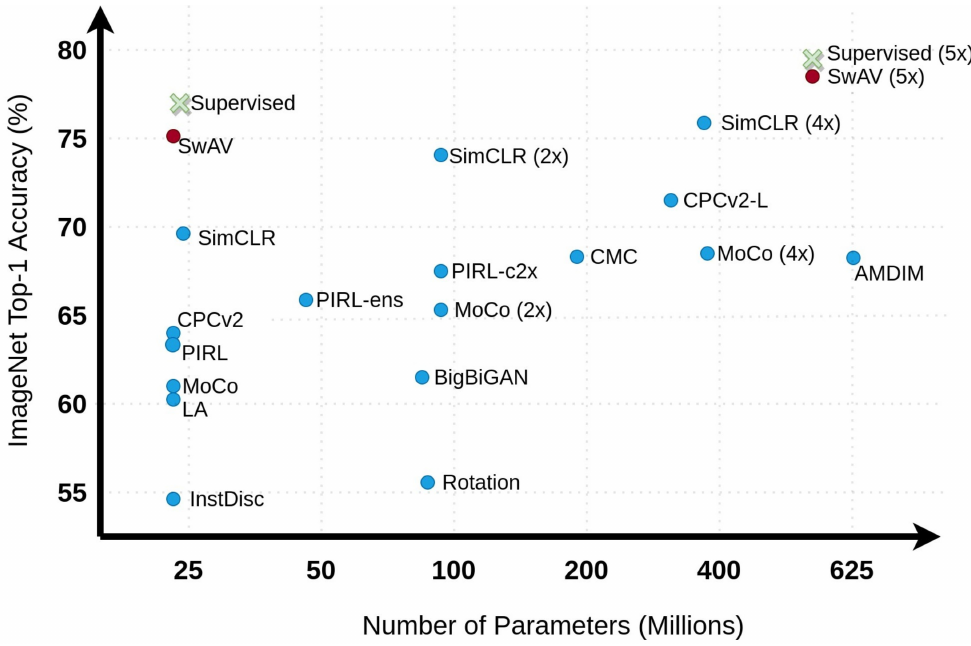
Figure 3. Top-1 classification accuracy of different contrastive learning methods against baseline supervised method on